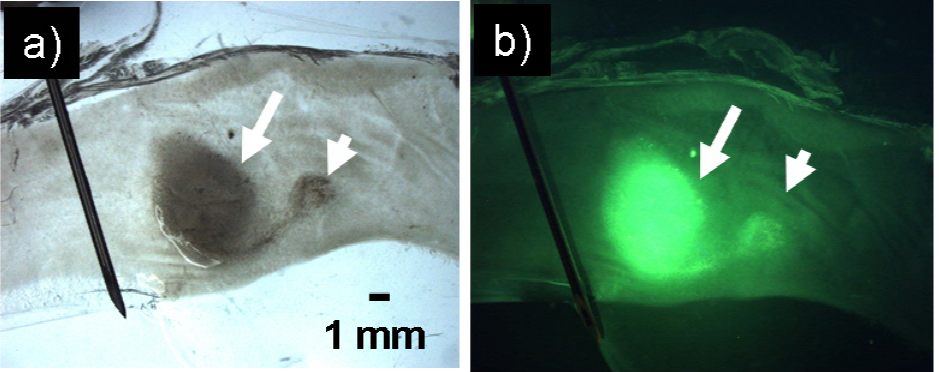
FIGURE 7. Example of in vivo targeting of carcinoembrionic antigen (CEA) in colonic adenomas developing in a mouse model. (a) Transmitted white light image of resected mouse colon showing dysplastic lesions (arrows) and (b) corresponding fluorescence image of the bright green–emitting QDots conjugated to a monoclonal antibody recognizing CEA, which is overexpressed in dysplastic lesions. Note the intense green fluorescence of the adenomas, indicating selective targeting of the agent and significant enhancement of the tumor-to-normal